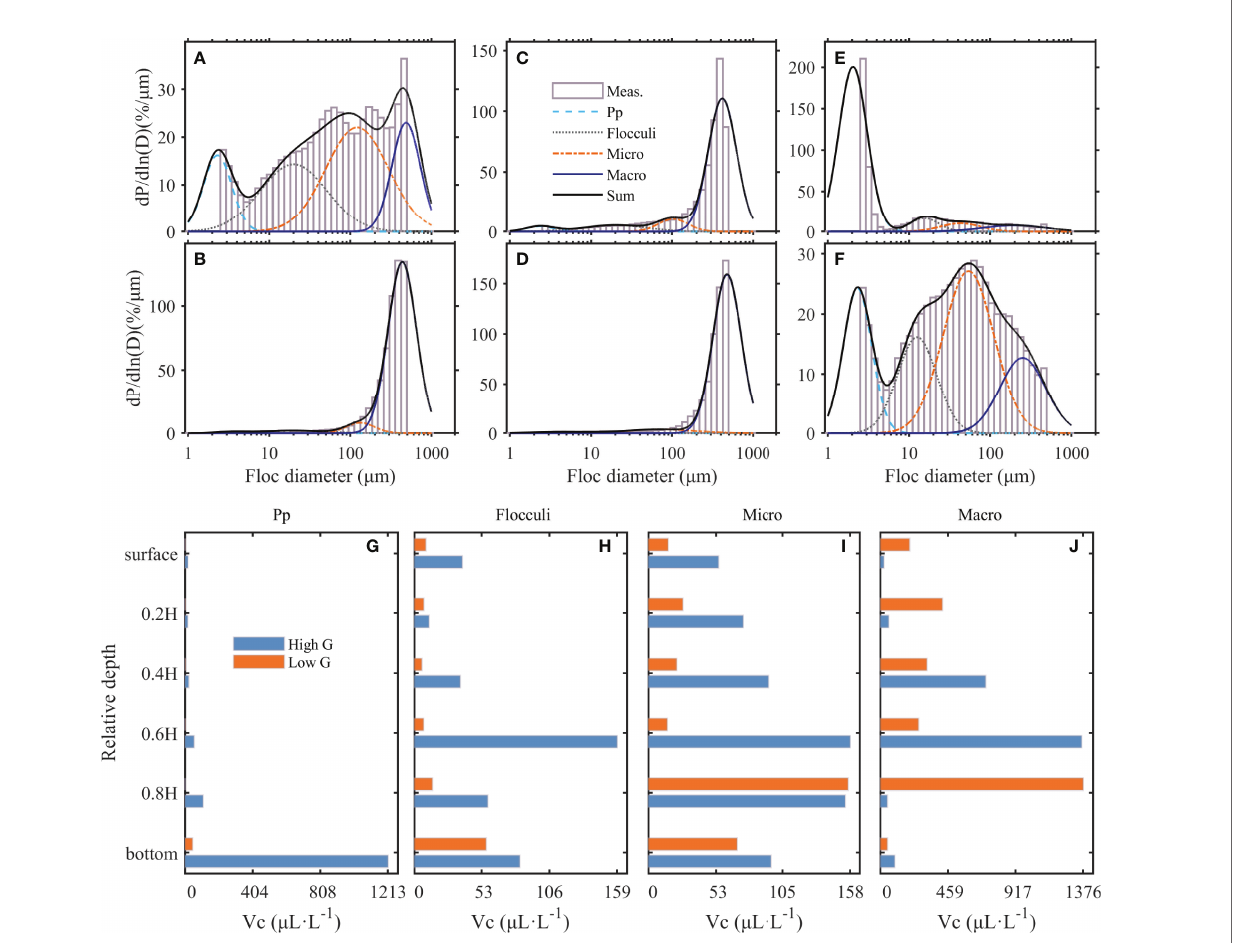
FIGURE 11 | (A, C, E) FSDs at the surface, middle, and bottom layers within high turbulent shear and SSC conditions (High G , shown in Figures 4B, C , the blue dots); (B, D, F) FSDs at the surface, middle, and bottom layers within low turbulent shear and SSC conditions (Low G , shown in Figures 4H, I , the orange dots). Meas. presents a FSD measured by the LISST instrument, and Sum indicates the superposition of the decomposed FSDs. (G – J) Different fl oc fraction volume concentration variation in the relative depth from the surface layer to the bottom layer, and H in High and Low G conditions were 4.05 and 4.48 m measured by the ADCP,